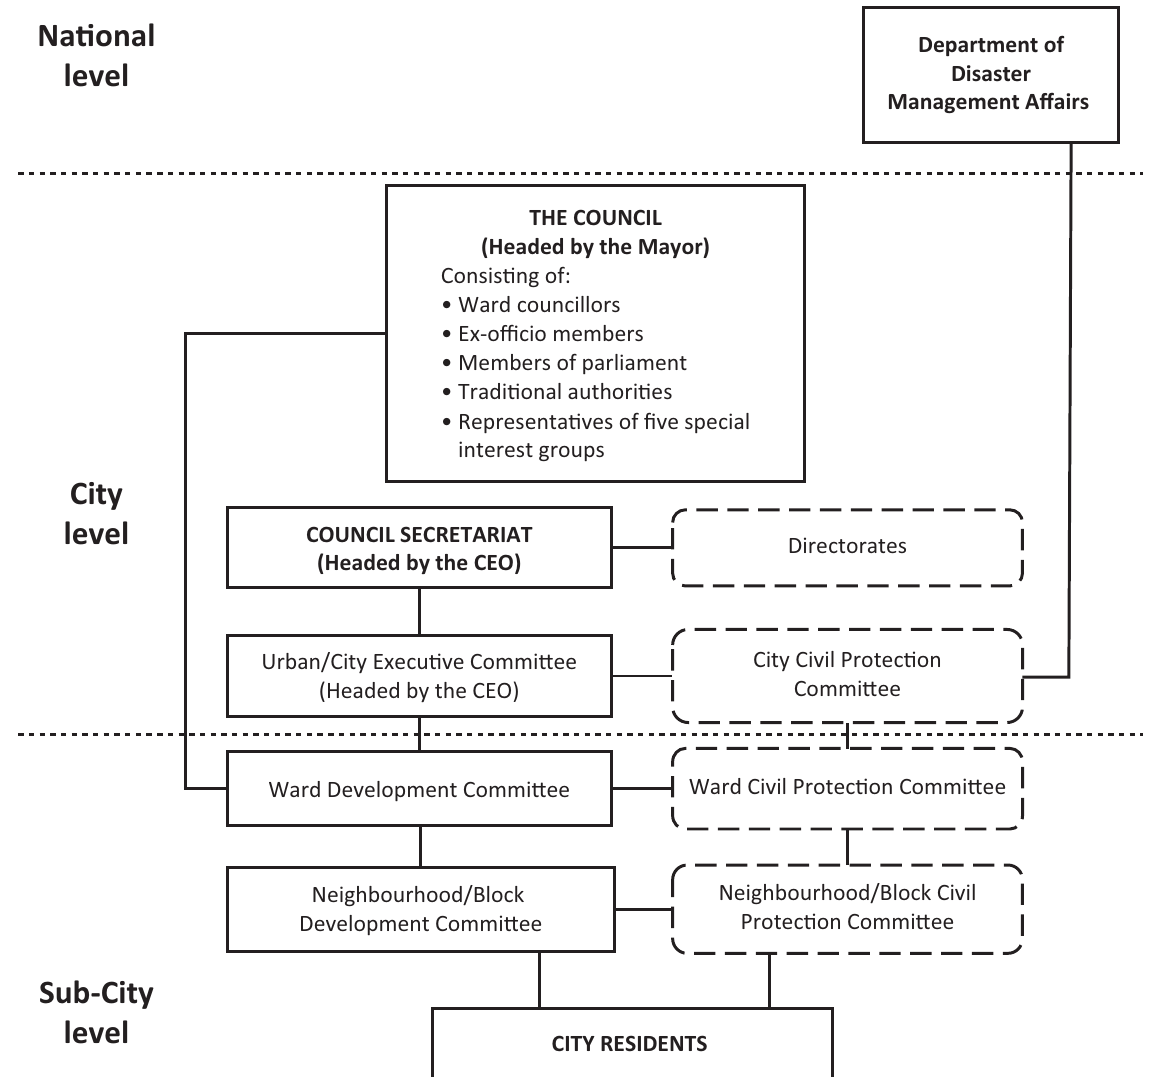
Figure 2. Local government structure. Source: Author’s work, adapted from Ministry of Local Government and Rural Development